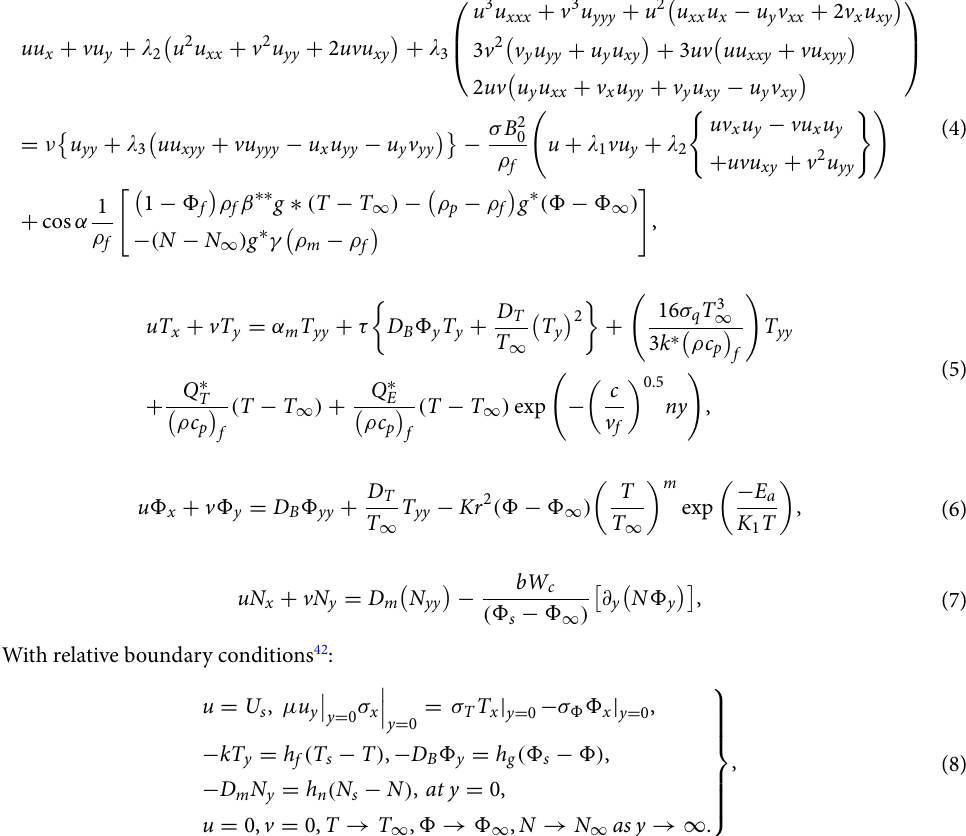
(cid:31) (cid:31) (cid:31) 1 = 2 = 3 = 0 ) .